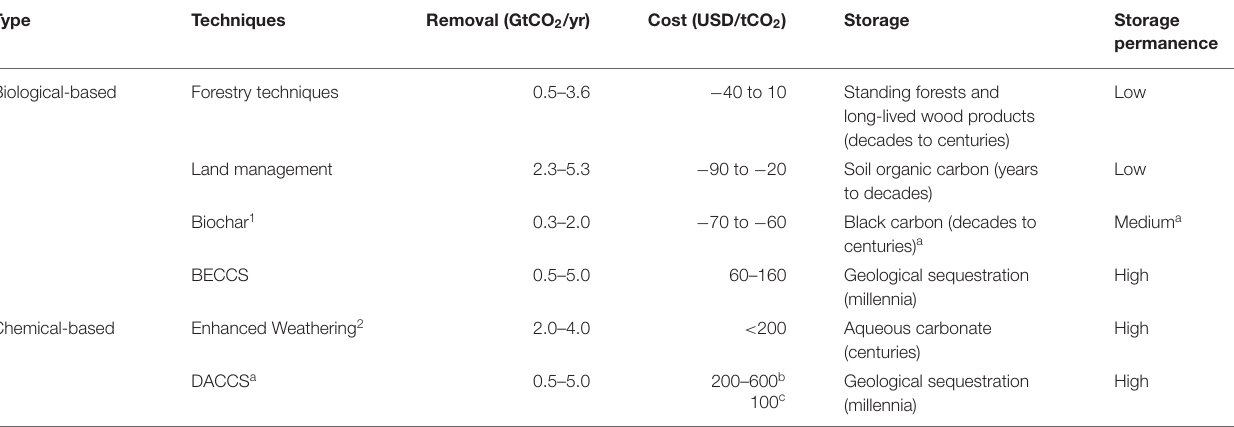
TABLE 1 | Overview of potential, breakeven cost, duration of storage, and likelihood of release for selected